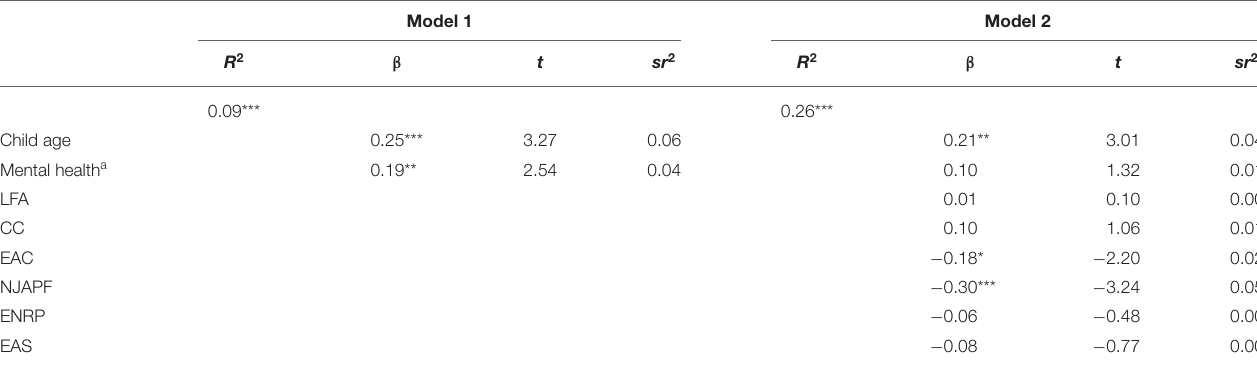
TABLE 6 | Regression analysis of demographic and mindful parenting scale predictors of child internalizing problems (SDQ Internalizing), for mothers of children aged 2–18 years ( n =